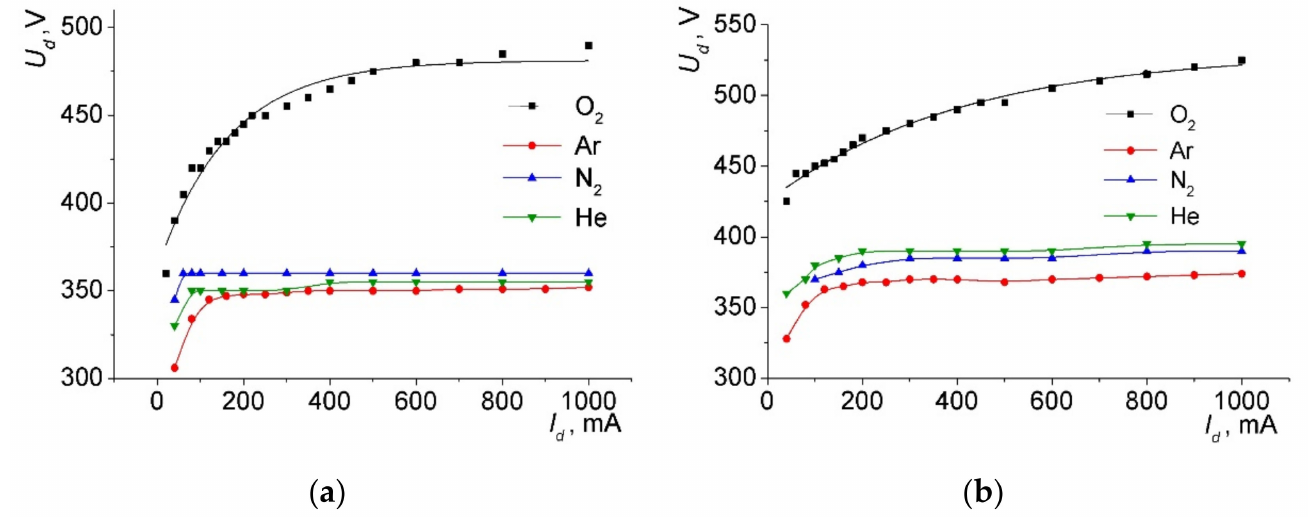
Figure 2. Characteristics of the discharge in oxygen, argon, nitrogen, and helium at various pressures: ( a ) 4.2 Pa and ( b ) 2